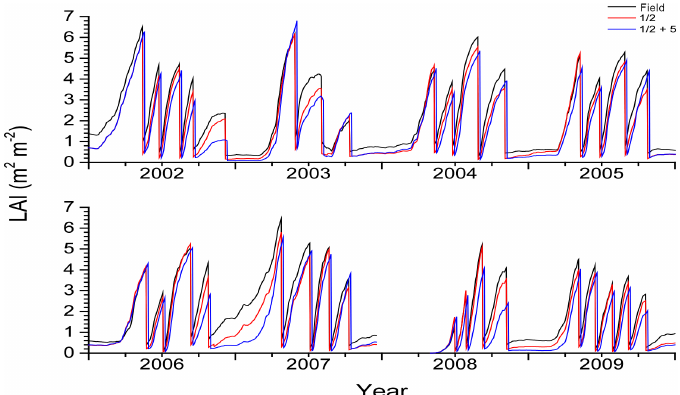
Figure 6. LAI modelled from 2002 through 2009, with LAI after each cut reduced to half of that estimated from the field experiment without or with a delay of 5 days at the Oensingen intensively managed